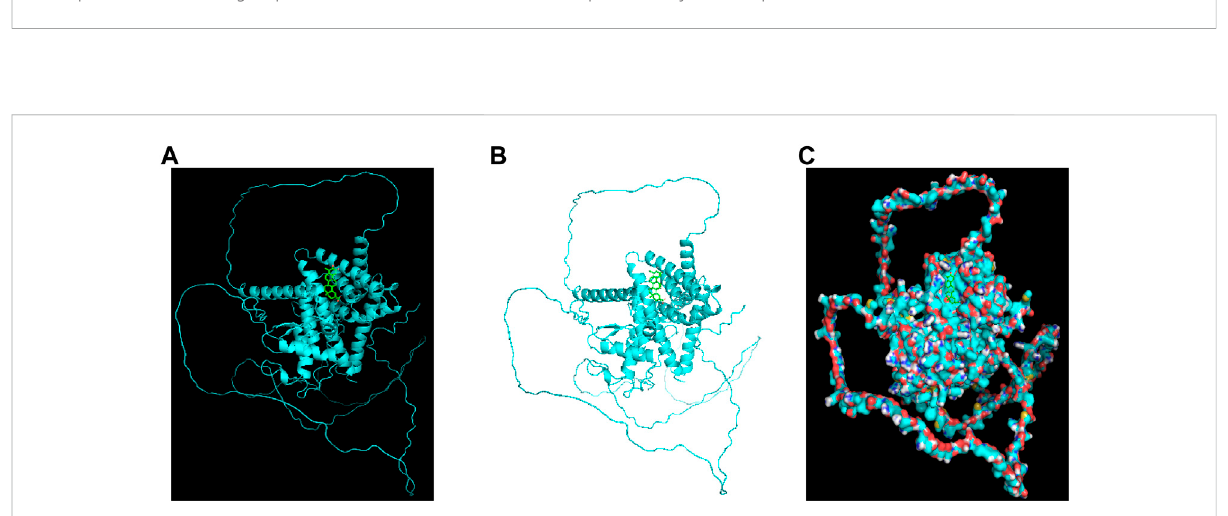
FIGURE 9 Celastrol docks with NR1D2 molecules. Molecular docking of the small-molecule ligand celastrol to the protein receptor of the target gene NR1D2 . (A,B) Lowest free energy molecular docking. (C) Molecular docking of the lowest free energy protein